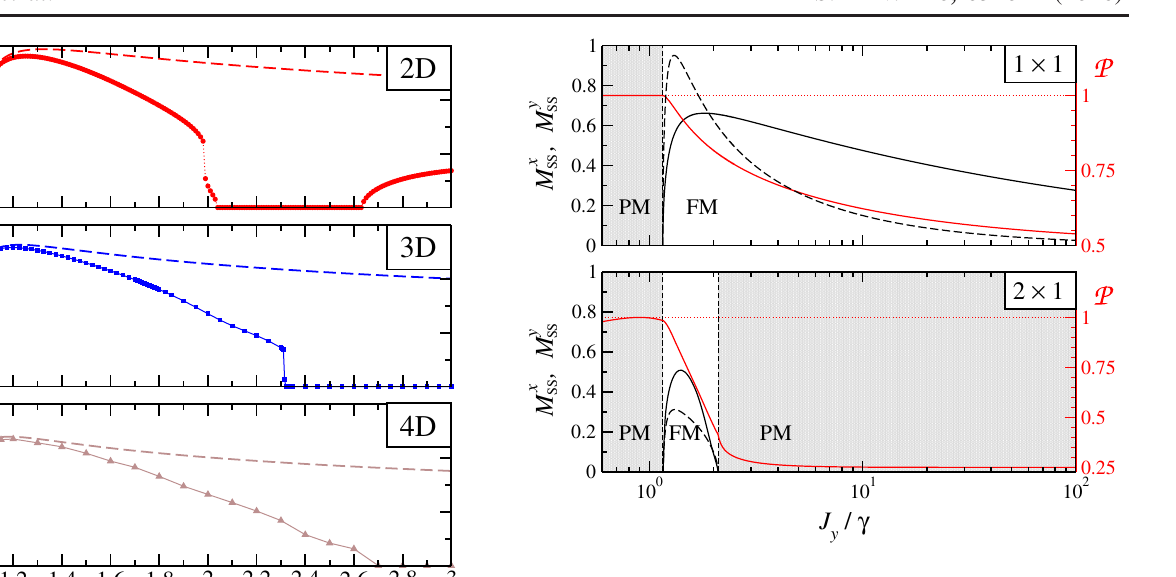
FIG. 15. Magnetization along the x (solid black line) and y (dashed black line) directions and purity P ¼ Tr ½ ρ 2 (cid:2) (solid red SS line) as a function of J y , for fixed J x ¼ 0 . 9 , J z ¼ 1 . The single- site MF ( 1 × 1 , top panel) predicts a PM phase for J y < J c y and a FM phase for J y > J c y . On the contrary, according to a CMF analysis ( 2 × 1 , lower panel), the FM phase shrinks down to